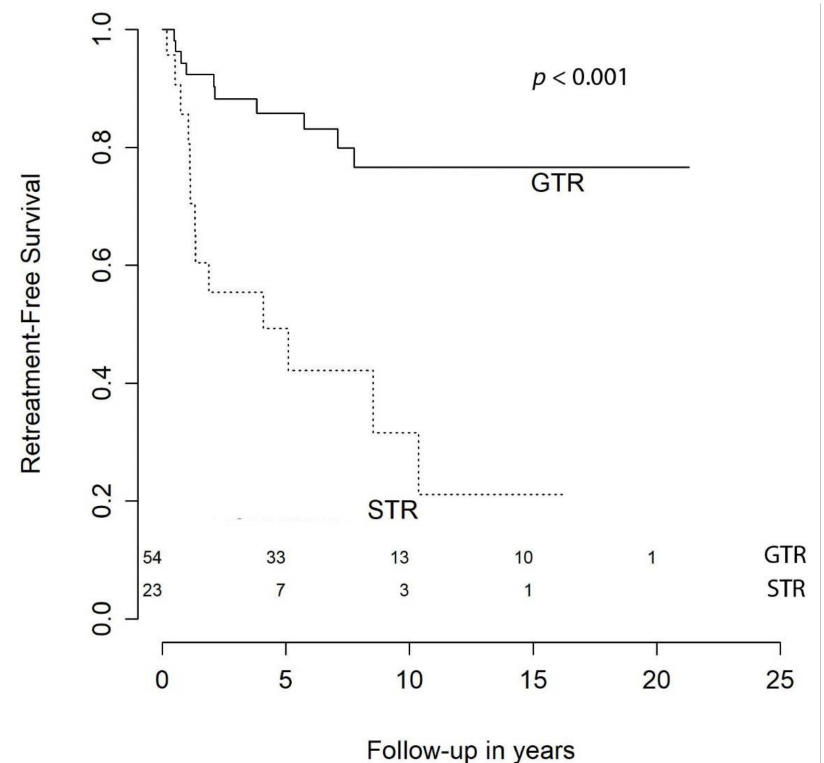
Figure 2. Retreatment-free survival by extent of